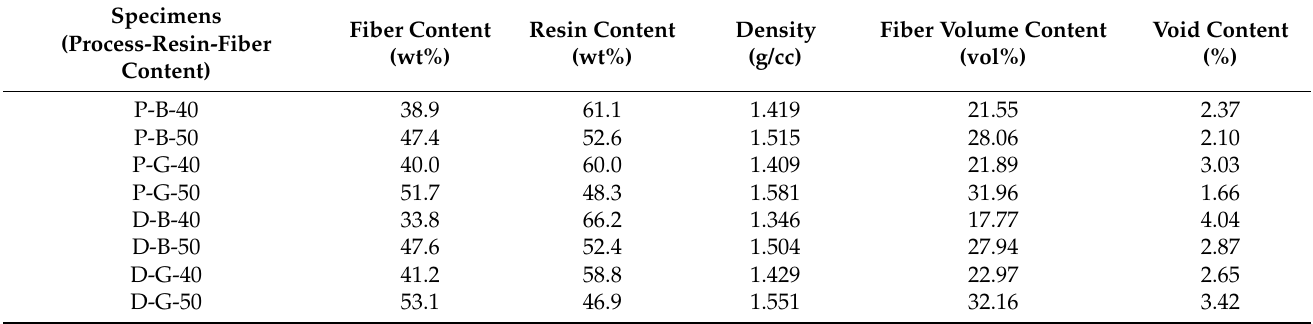
Table 5. Physical characteristics of the GF/PA6